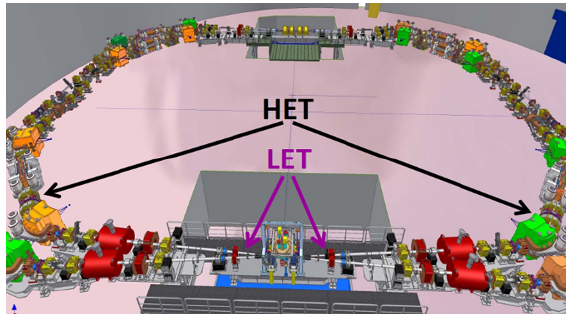
Figure 2. HET and LET positions along the beam line. The LET calorimeters are placed at both sides of the interaction point and are enclosed in the KLOE apparatus volume. The HET calorime- ters are placed at both sides of the interaction point, but outside the KLOE volume.